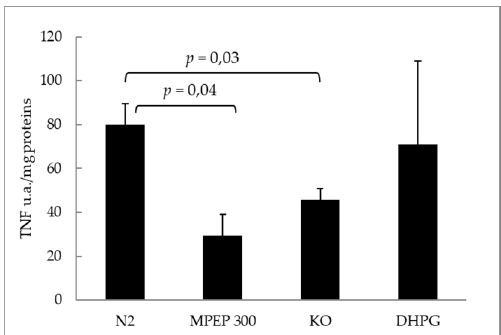
Figure 10. TNF- α release measured at the end of 120 ′ reperfusion was significantly lower in livers treated with MPEP and livers from mice KO for mGluR5 (Tukey’s test).